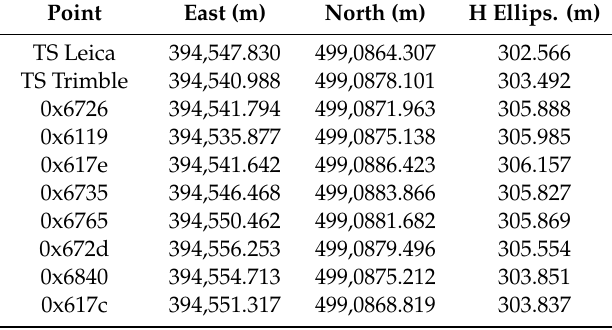
Table 2. Coordinates of the geo-referenced topographic network and UWB anchors in UTM-WGS84 32N. Point East (m)